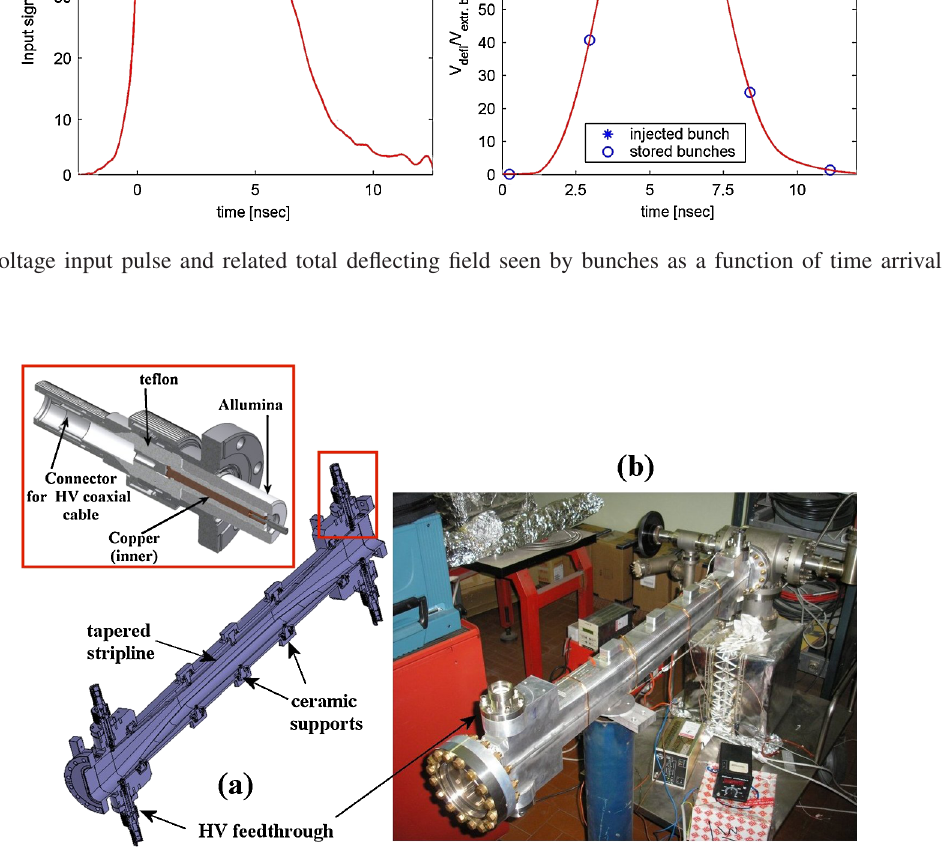
FIG. 9. (a) Final mechanical drawing of the kicker with a detail of the high voltage feedthrough. (b) Picture of the final realized